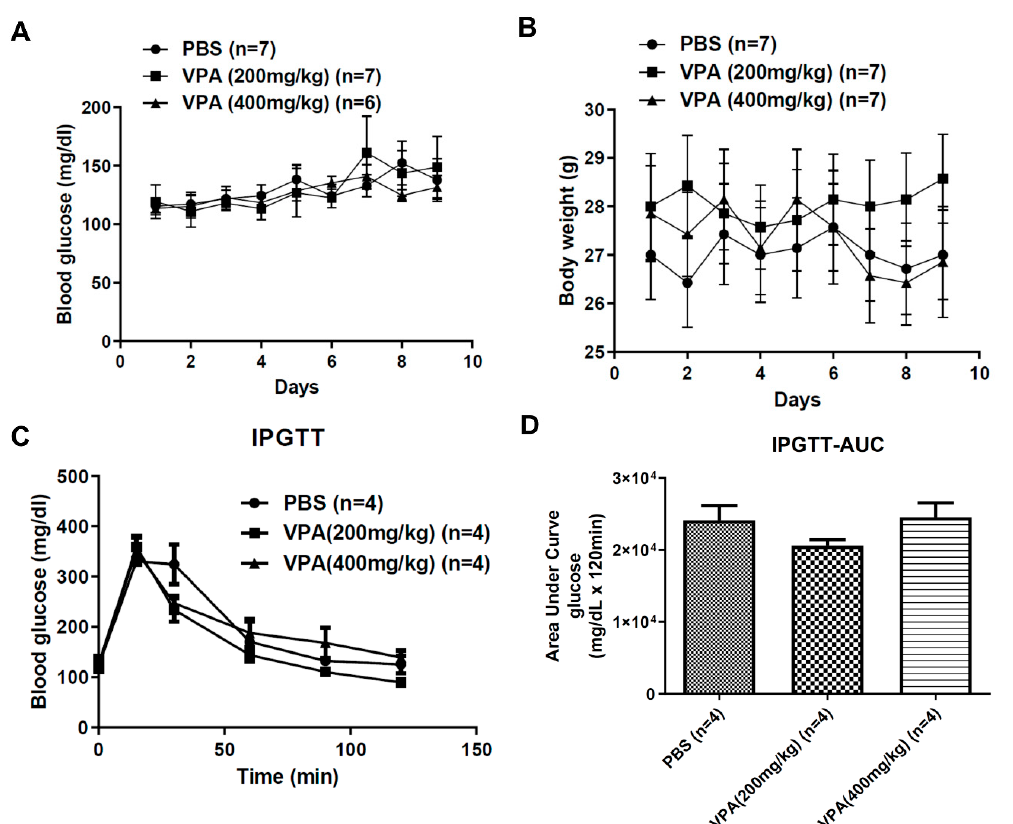
Figure 3. The effect of VPA treatment in the body weight and insulin secretion of NOD recipients. ( A ) There were no significant differences in the body weight and ( B ) blood glucose between PBS-treated and VPA-treated mice ( p > 0.05, n = 7). ( C ) IPGTT was performed to examine the influence of VAP on the metabolism of blood glucose. Glucose was i.p. injected into NOD mice at 2 g/kg concentration following a fast for 6 h. ( D ) Area under curve (AUC) also showed no significant differences ( n = 4).